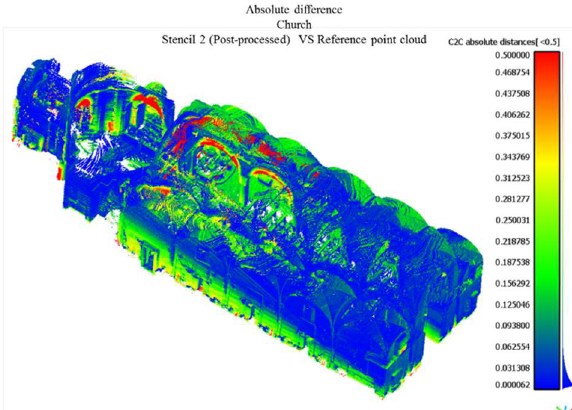
Figure 10. Comparison of point clouds between the real-time solution of the Stencil 2 and the reference model.